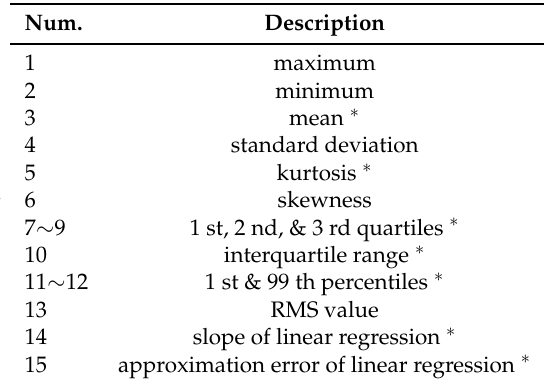
Table 1. List of statistical and regression measures applied to low-level descriptors. Num. Description 1 maximum 2 minimum 3 mean ∗ 4 standard deviation 5 kurtosis ∗ . 6 skewness 7 ∼ 9 1 st, 2 nd, & 3 rd quartiles ∗ 10 interquartile range ∗ 11 ∼ 12 1 st & 99 th percentiles ∗ 13 RMS value 14 slope of linear regression ∗ 15 approximation error of linear regression